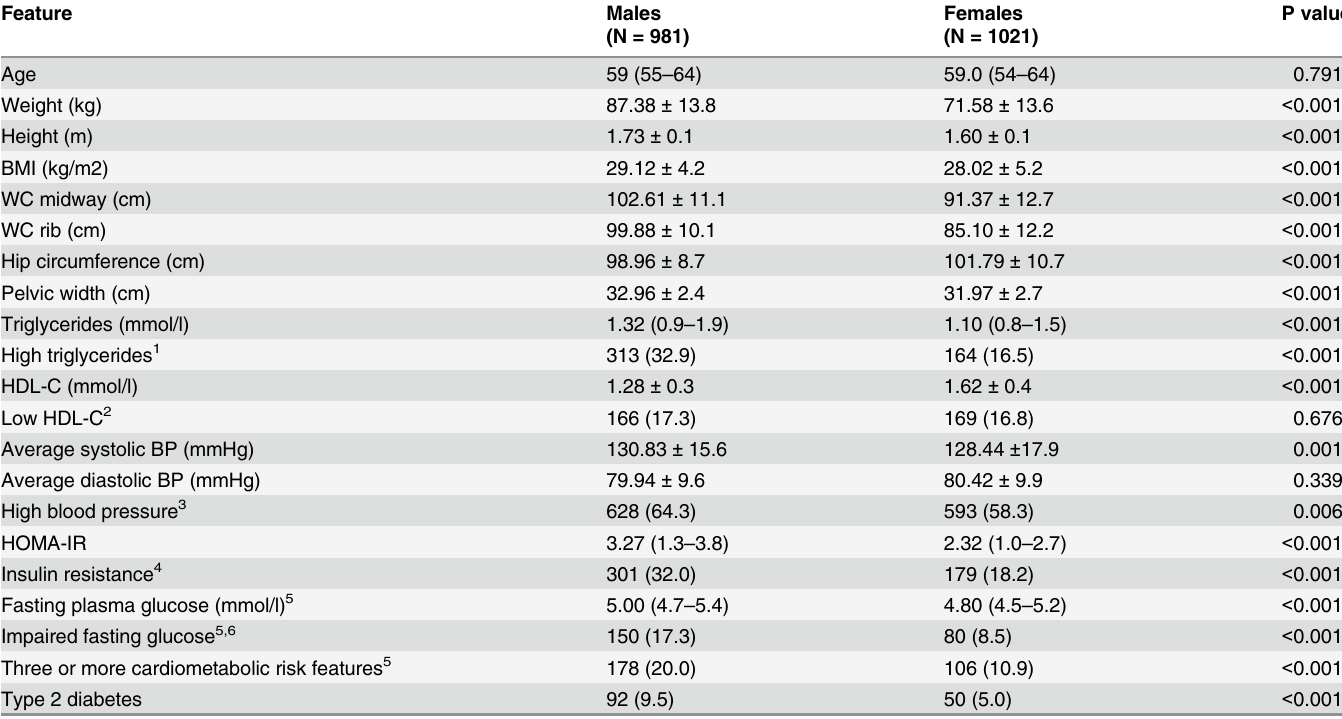
Table 1. Characteristics of the study